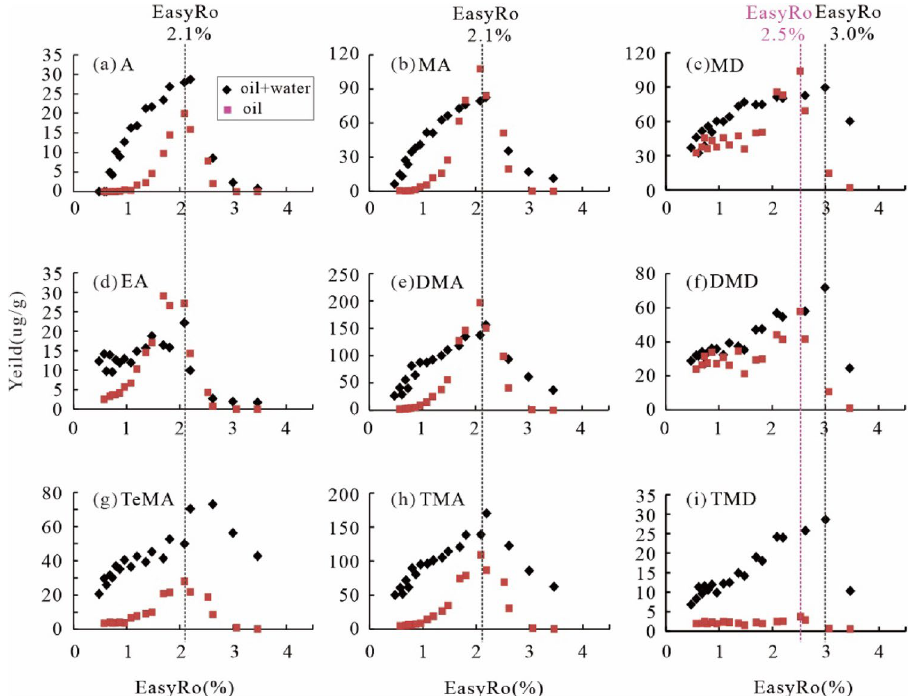
Figure 3. Variation in the yields (µg/g oil) of different types of diamondoids generated from hydrothermal and Fang et al. 13 anhydrous pyrolysis of oil with EasyRo (%): ( a ) A = adamantanes, ( b ) MA = methyladamantanes, ( c ) MD = methyldiamantanes, ( d ) EA = ethyladamantanes, ( e ) DMA = dimethyladamantanes, ( f ) DMD = dimethyldiamantanes, ( g ) TeMA = Tetramethyladamantane, ( h ) TMA = trimethyladamantanes, ( i ) TMD =